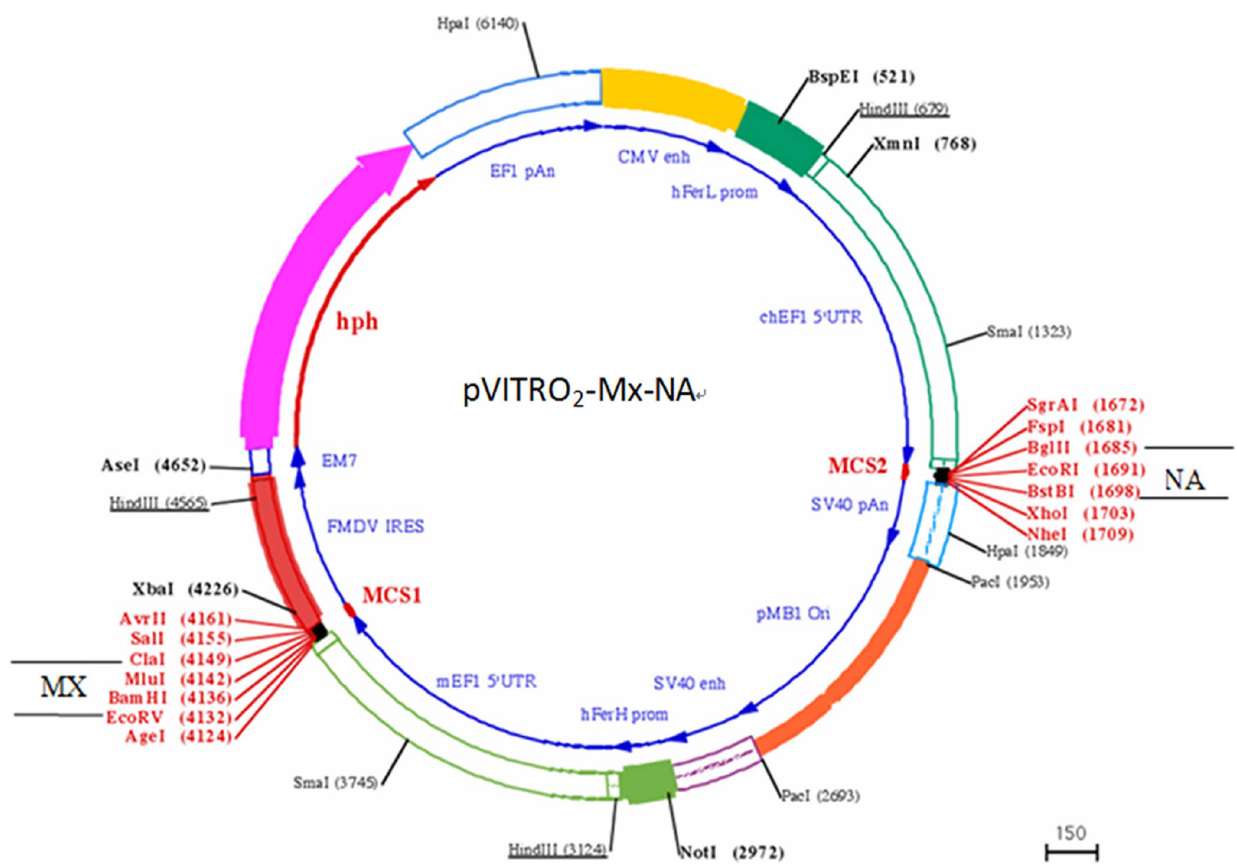
Figure 1. The plasmid profile of pVITRO 2 -Mx-NA. Plasmid pVITRO 2 -hygro-mcs was conducted, then Mx was inserted into MCS1 (Eco R V and Cla I) and NA was insereted into the MCS2( Eco R I and Xho I restriction site).